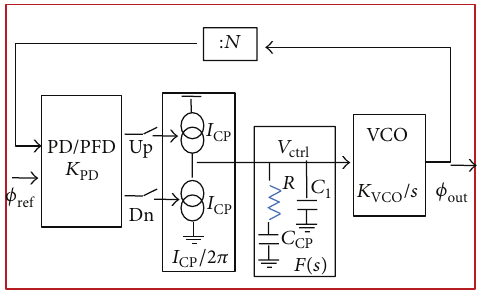
Table 3: Rule base for